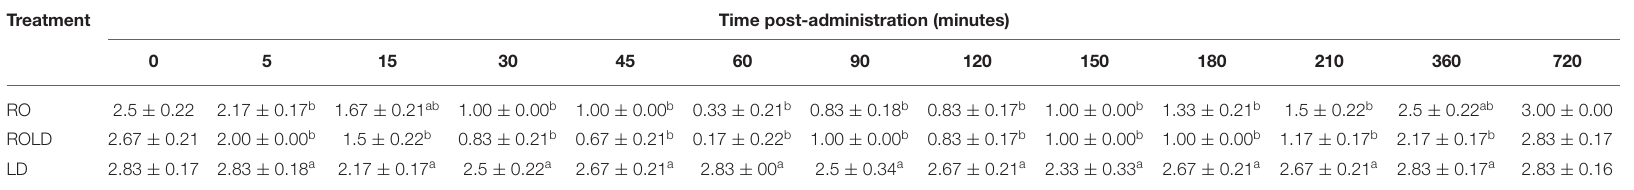
TABLE 4 | Ataxia scores (median and range) pre-epidural and post-epidural injection of romifidine (RO) (50 µ g kg − 1 ), romifidine-lidocaine (ROLD) (50 µ g and 0.3mg kg − 1 ) and lidocaine (LD) (0.3mg kg − 1 ) in camels ( n = 18). Treatment